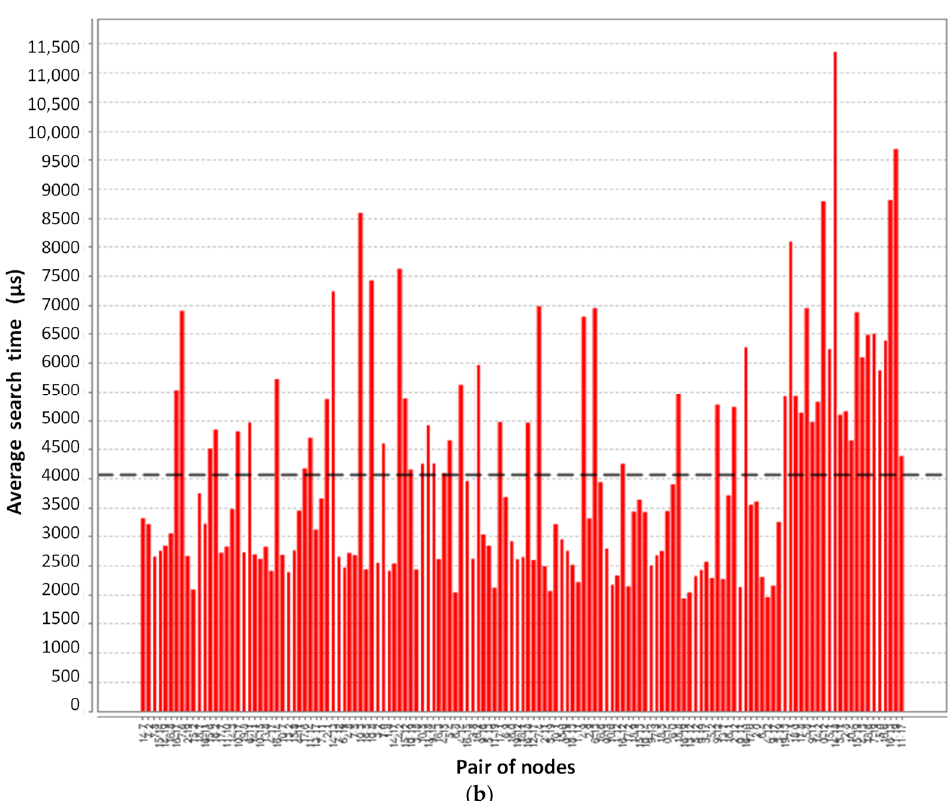
Figure 13. Estimation of the route search duration in the network using the k-means clustering algorithm ( a ) and its improved version ( b ).